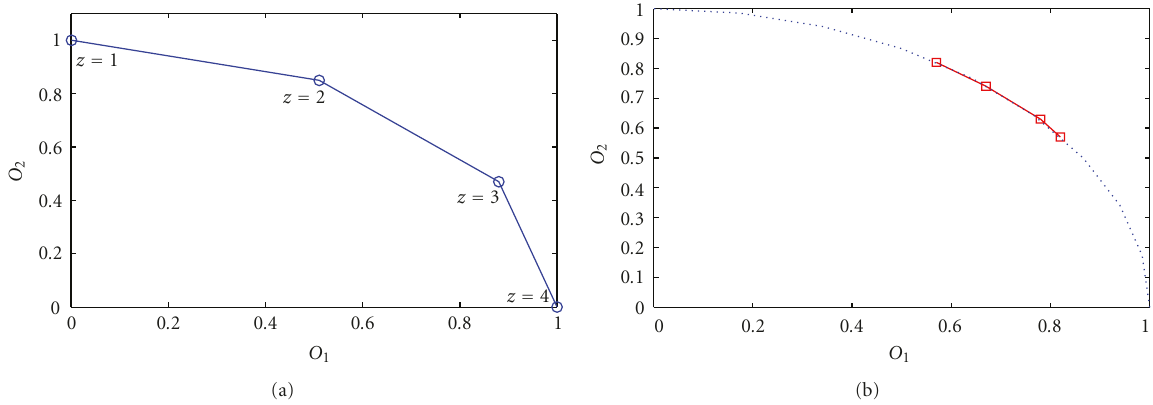
Figure 1: Example of two sets of solutions S a